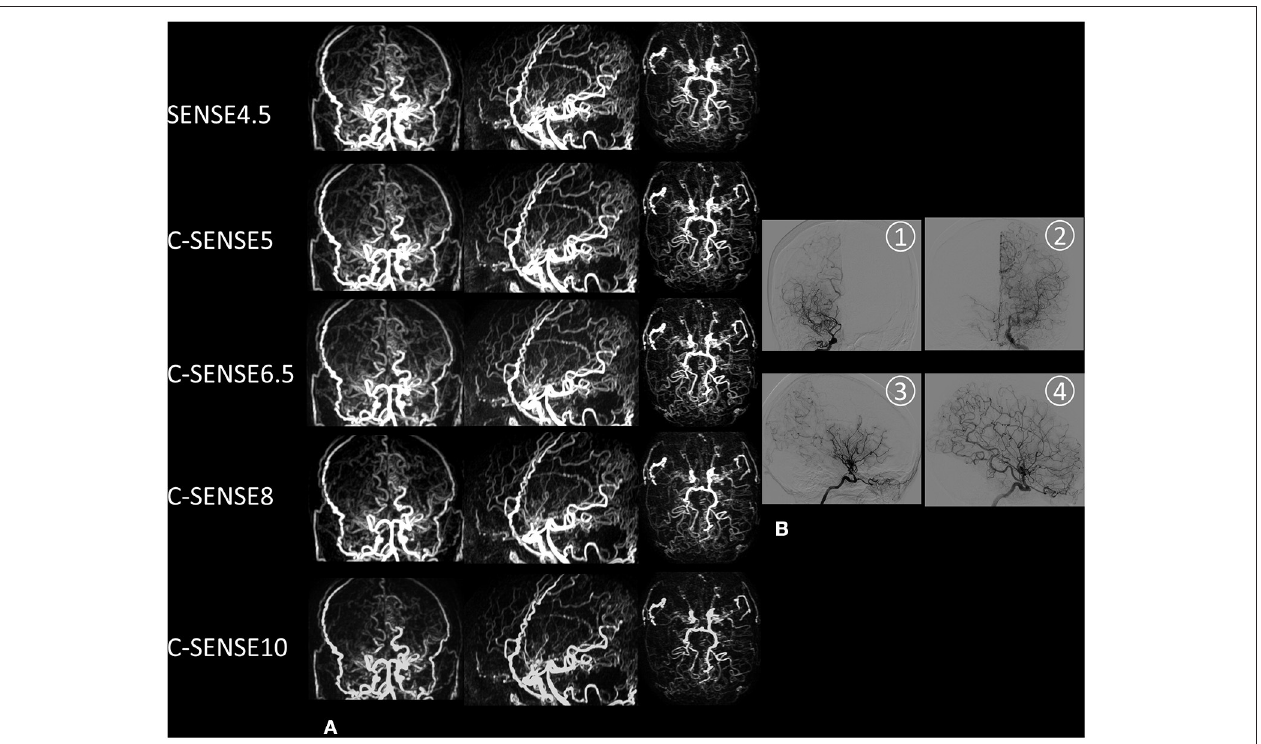
FIGURE 5 | A 50-year-old woman with moyamoya disease. (A) Coronal, sagittal, and axial maximum intensity projection images acquired by 4D-PACK combined with different acceleration factors. SENSE4.5, C-SENSE5, and C-SENSE6.5 acquisitions provided better visualization of distal arteries and collaterals than C-SENSE8 and C-SENSE10. The distal artery is slightly blurred in images acquired by C-SENSE8, and some of them disappear in images acquired by C-SENSE10. (B) Anteroposterior and lateral digital subtraction angiography images of the right (1, anteroposterior view; 3, lateral view) and left (2, anteroposterior view; 4, lateral view) internal carotid arteries. The bilateral middle cerebral arteries are occluded and surround many collaterals.